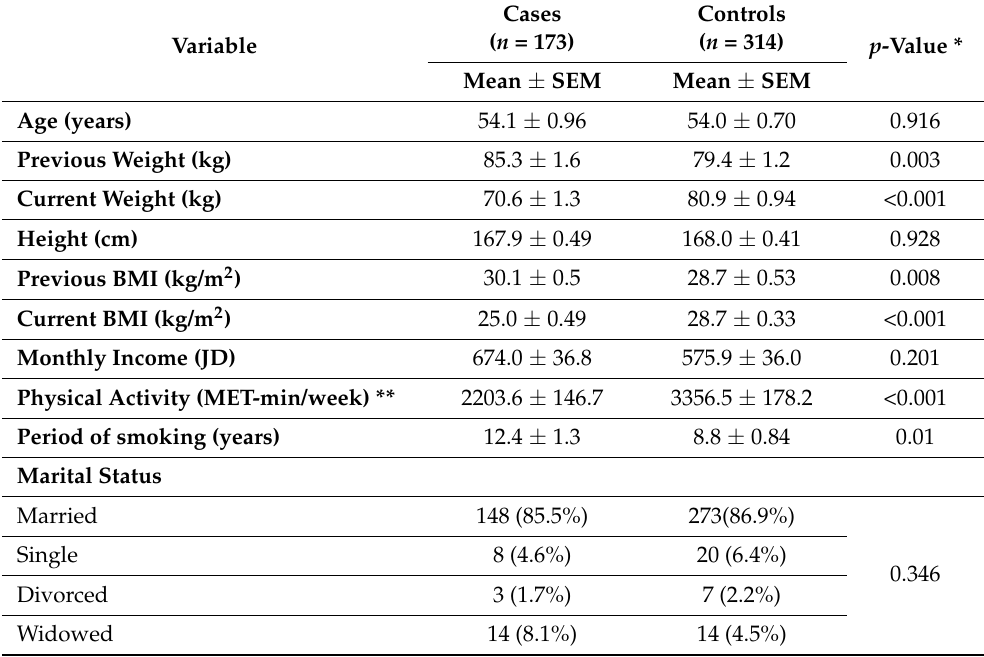
Table 1. Socio-demographic characteristics of the study population.